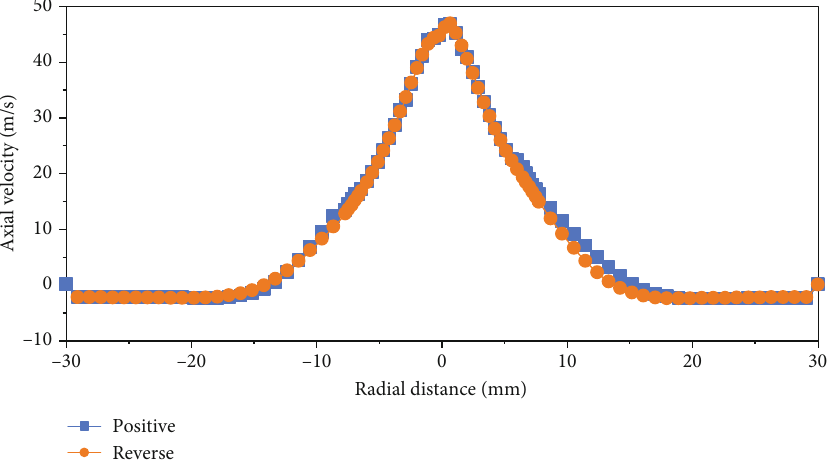
Figure 19: Axial velocity distribution of positive and reverse swirling in h / d = 8